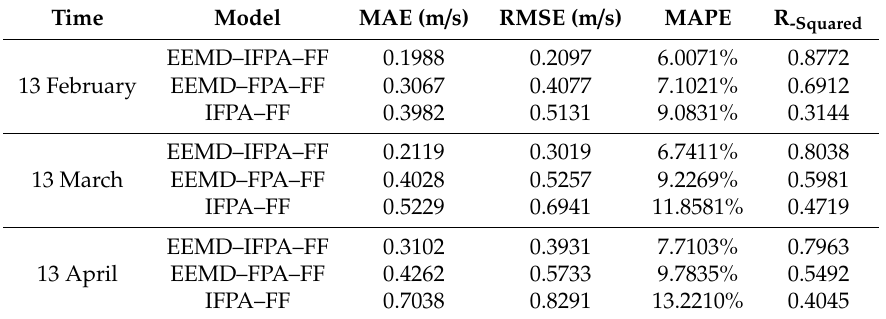
Table 7. Error comparison of training samples with existing models.